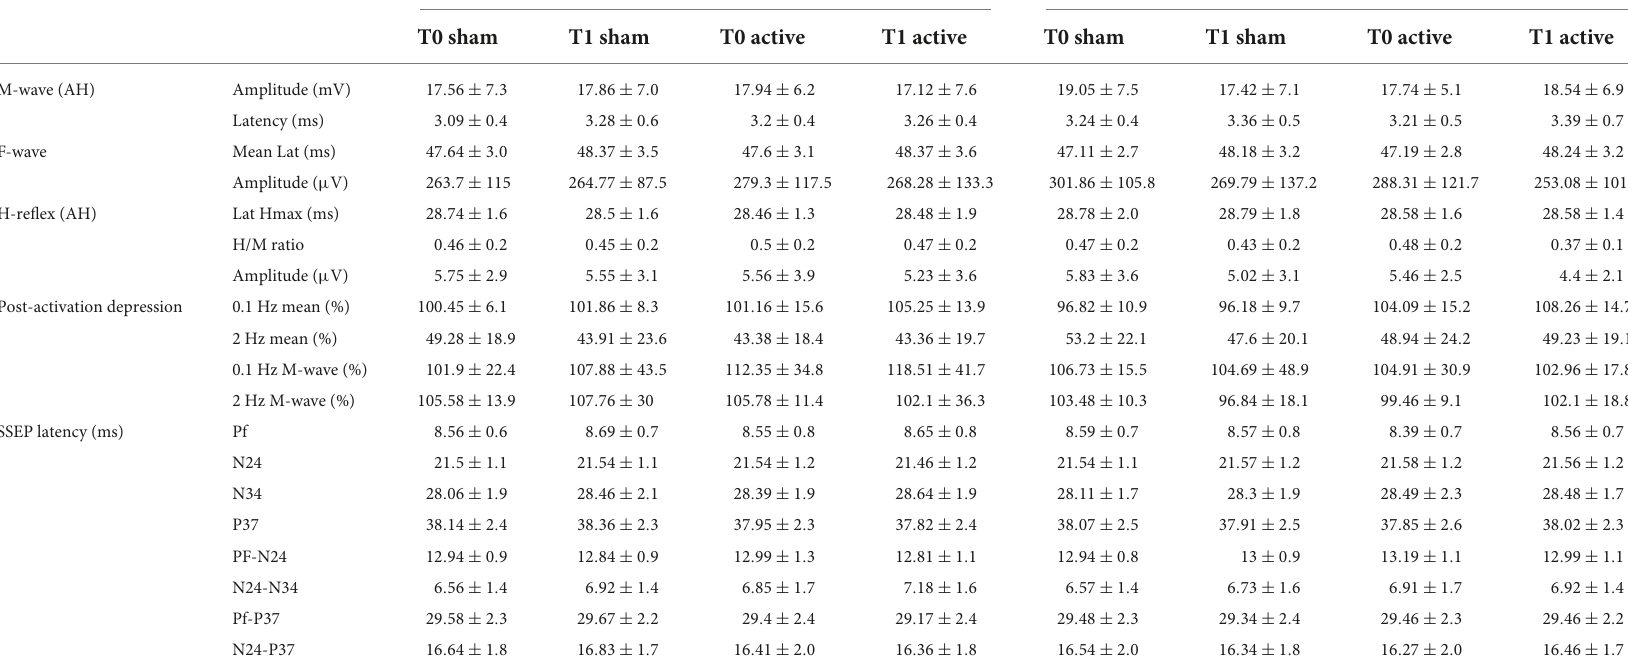
TABLE 4 Neurophysiological responses for both lower limb before and after protocol ( N = 14). Neurophysiological